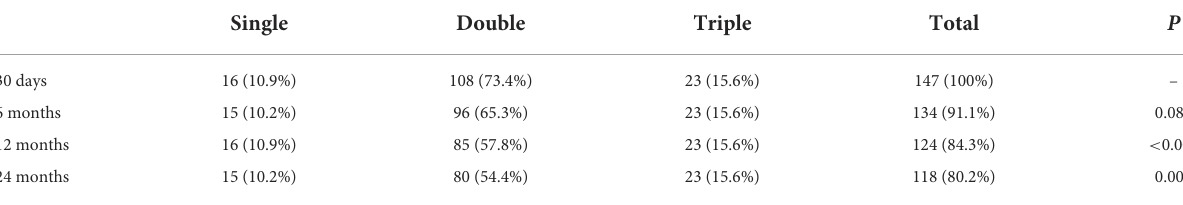
TABLE 5 Relationship between branching number and vessel patency.